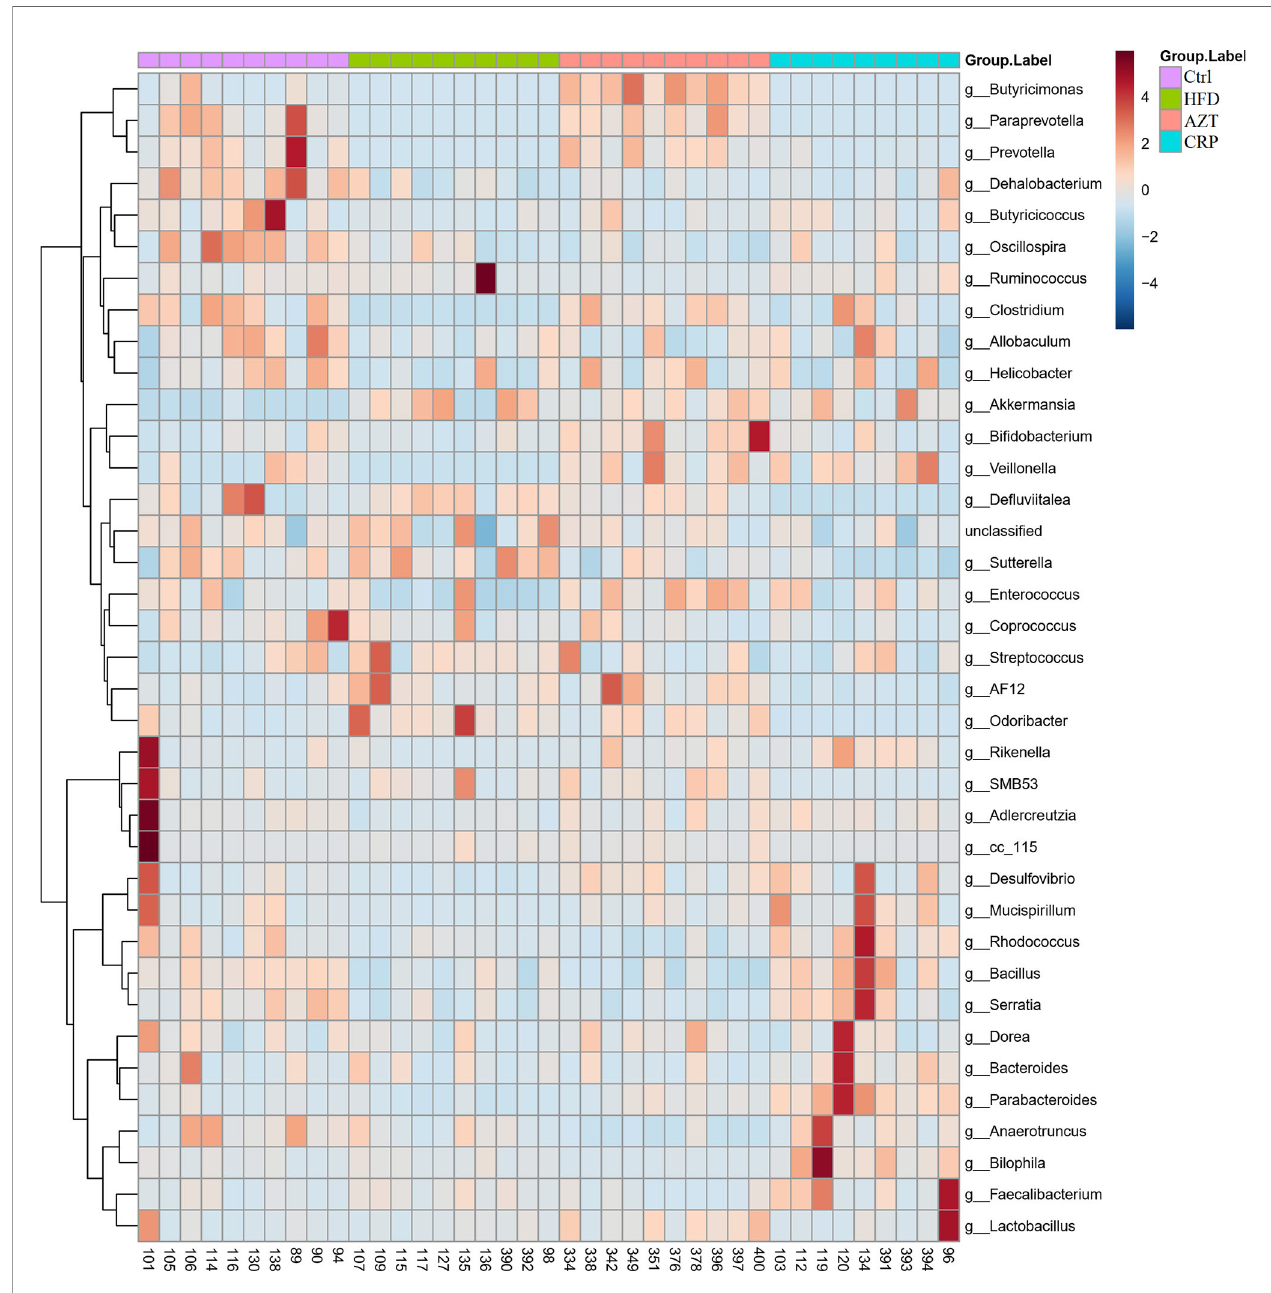
FIGURE 10 | Heat map at the genus level between the groups. Red indicates high values; blue indicates low